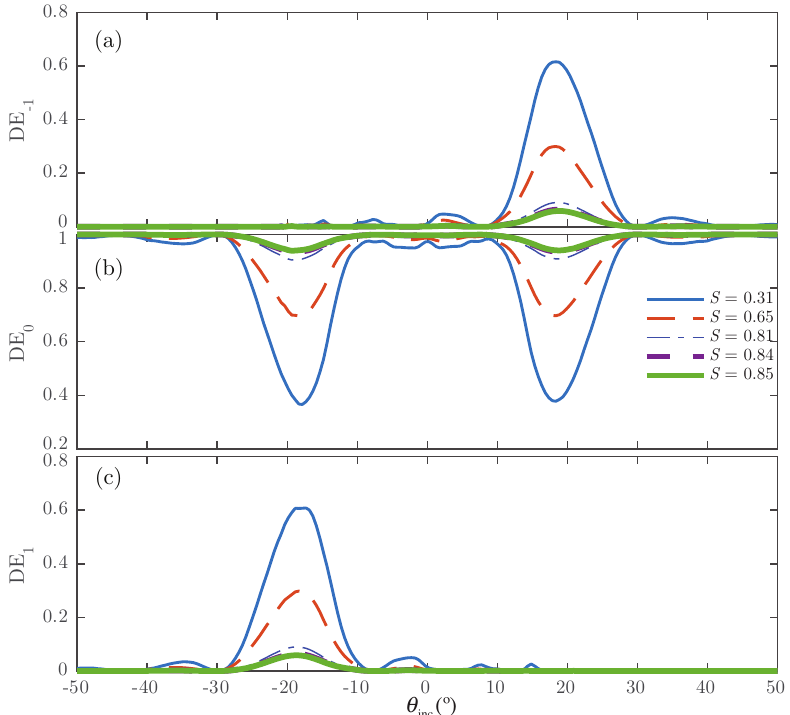
Figure 4. Diffraction efficiency as a function of the angle of incidence for different S parameter for Grating #1: ( a ) − 1st-order; ( b ) 0th-order; ( c )